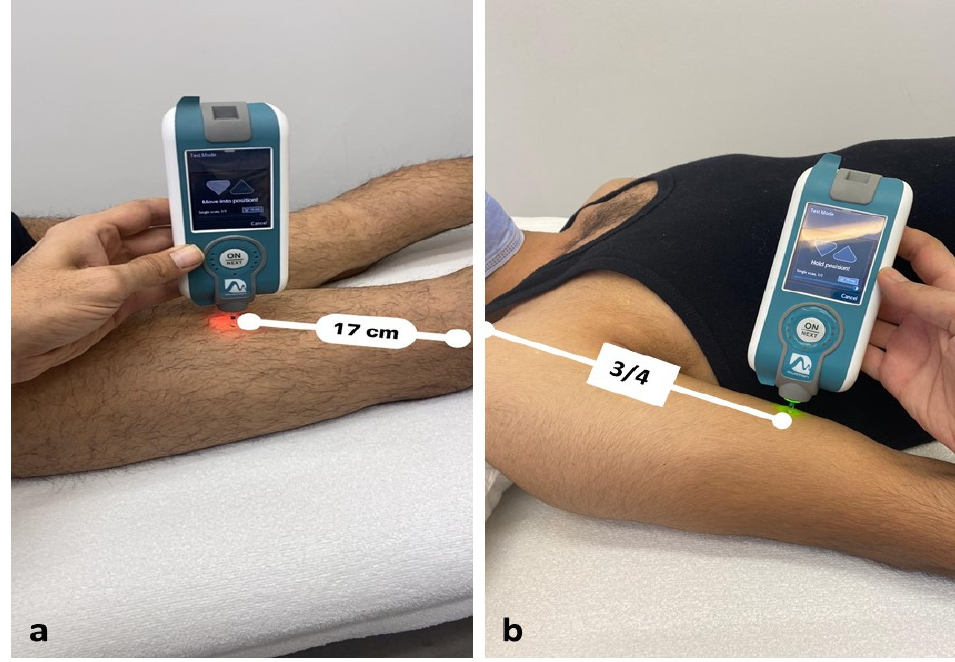
Figure 1. The reference points of muscles for myotonometric assessment: ( a ) biceps femoris; ( b ) biceps brachii .